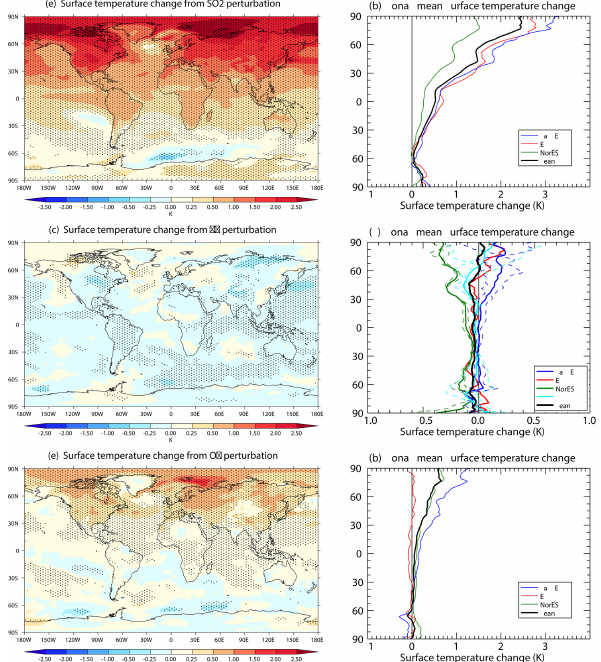
Figure 5. Annual average change in surface temperature for (a, b) SO 2 , (c, d) BC and (e, f) OC perturbations. Left column: multi- model mean maps. Right column: zonal mean. In (a, c, e) , stippling shows points where the response is significant at the 95% level (de- Figure 4. Summary of global mean annual average changes in (a, termined by a student’s t test using all years of all b) surface temperature, (c, d) all-sky TOA SW flux and (e, f) pre- cipitation. In the left panels the values shown for the BC simulations are the means for each model (where more than one simulation was run). The values for the individual BC simulations are shown in the right panels. The error bars indicate the 95% confidence interval √ n , where n is the number of years on the error in the mean (2 σ/ of data included in the mean; i.e. n is 50 × the number of ensemble members).